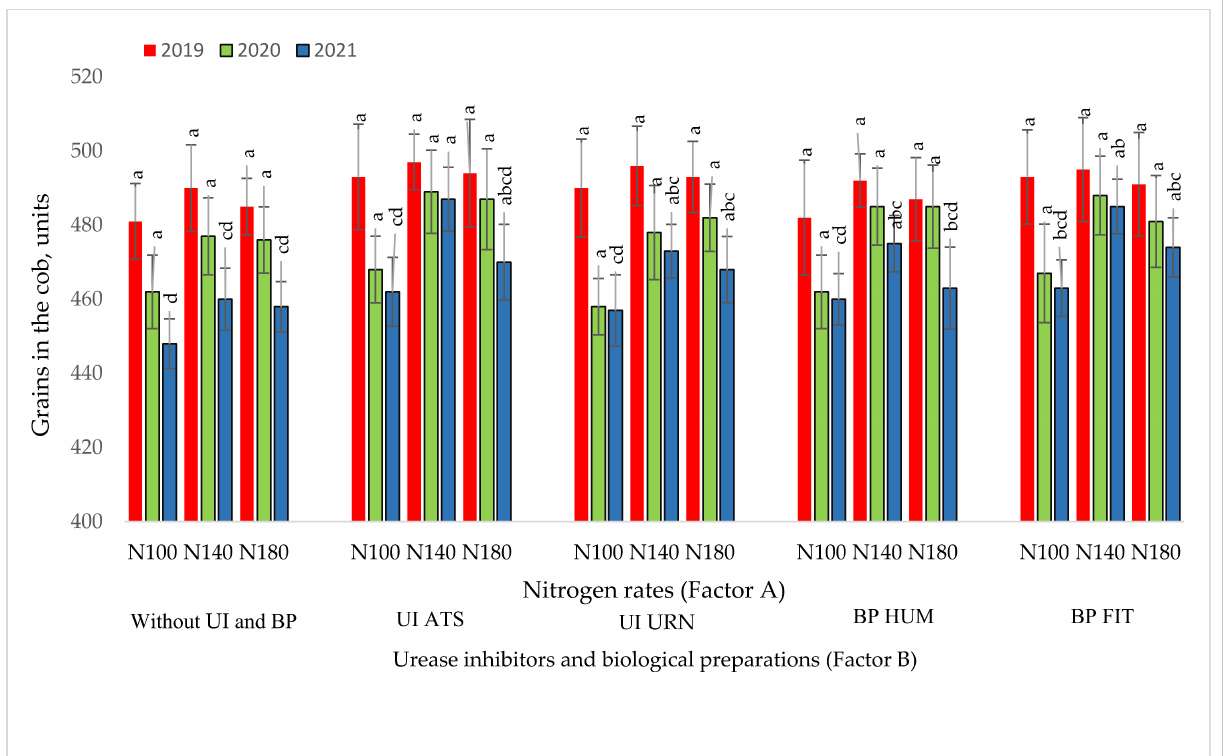
Figure 4. The influence of different nitrogen fertilizer rates, urease inhibitors, and biological prepara- tions on the number of maize grains in the cob, 2019–2021. UI—urease inhibitor; ATS—ammonium thiosulfate; URN—N-butyl-thiophosphoric triamide (NBPT) and N-propyl-thiophosphoric triamide (NPPT); BP—biological preparation; HUM—suspension of humic and fulvic acids; FIT—suspension of Ascophyllum nodosum . The differences between the means of the treatments with the different letters are significant ( p < 0.05). Vertical dashes indicate the mean error. Table 1. Dependence of maize grain yield and yield structure elements (y) on different rates